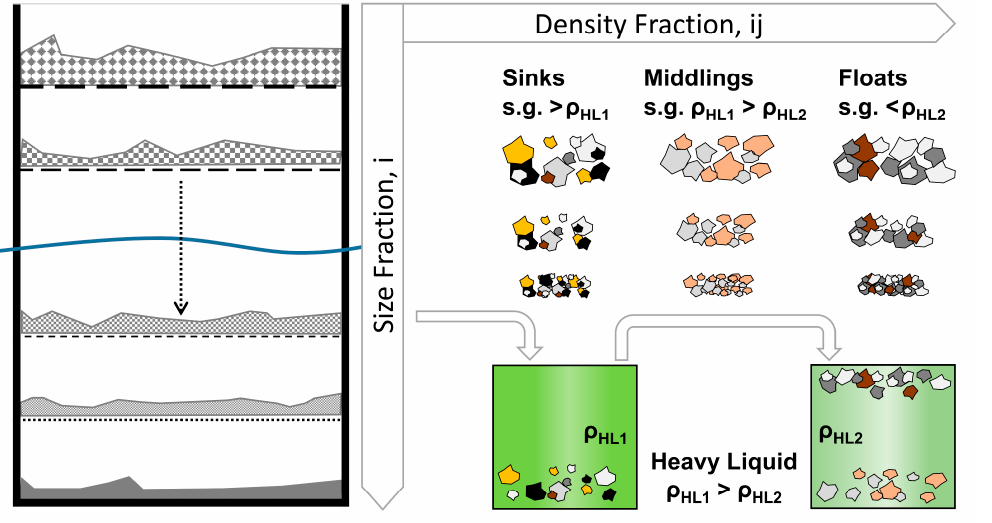
Figure 4. Sieve analysis and sink–float analysis results in a two-dimensional fractional analysis.